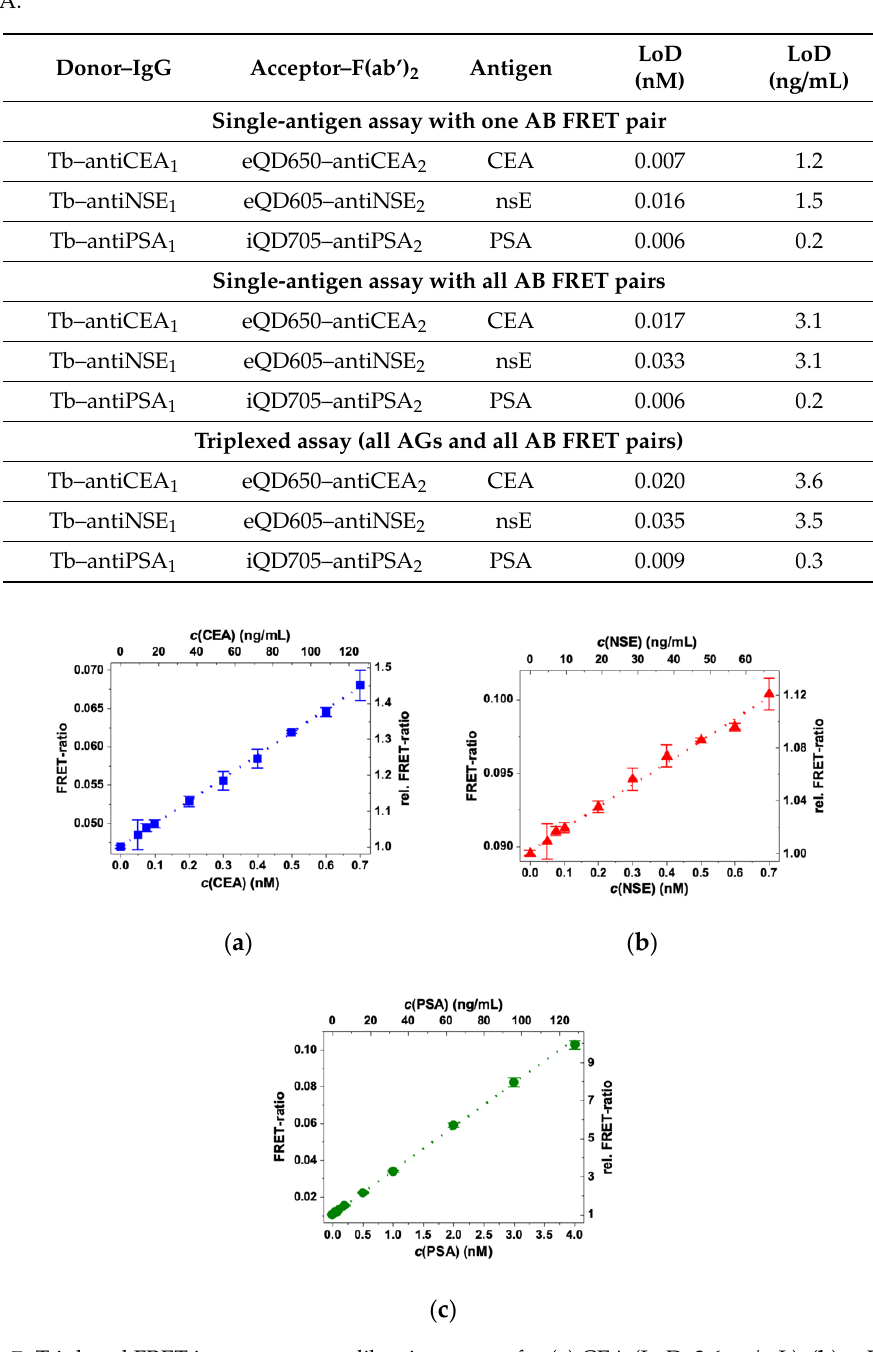
Figure 7. Triplexed FRET immunoassay calibration curves for ( a ) CEA (LoD: 3.6 ng/mL), ( b ) NSE (LoD: 3.5 ng/mL), and ( c ) PSA: LoD: 0.3 ng/mL. Dotted lines show the linear fits of the calibration curves. Table 3. LoDs overview of singleplex, “singleplex”, and triplex format of the FRET immunoassays. All the LoDs are below the clinical cut ‐ off levels: 5.0 ng/mL for CEA, 12.5 ng/mL for NSE, and 4.0 ng/mL for PSA.